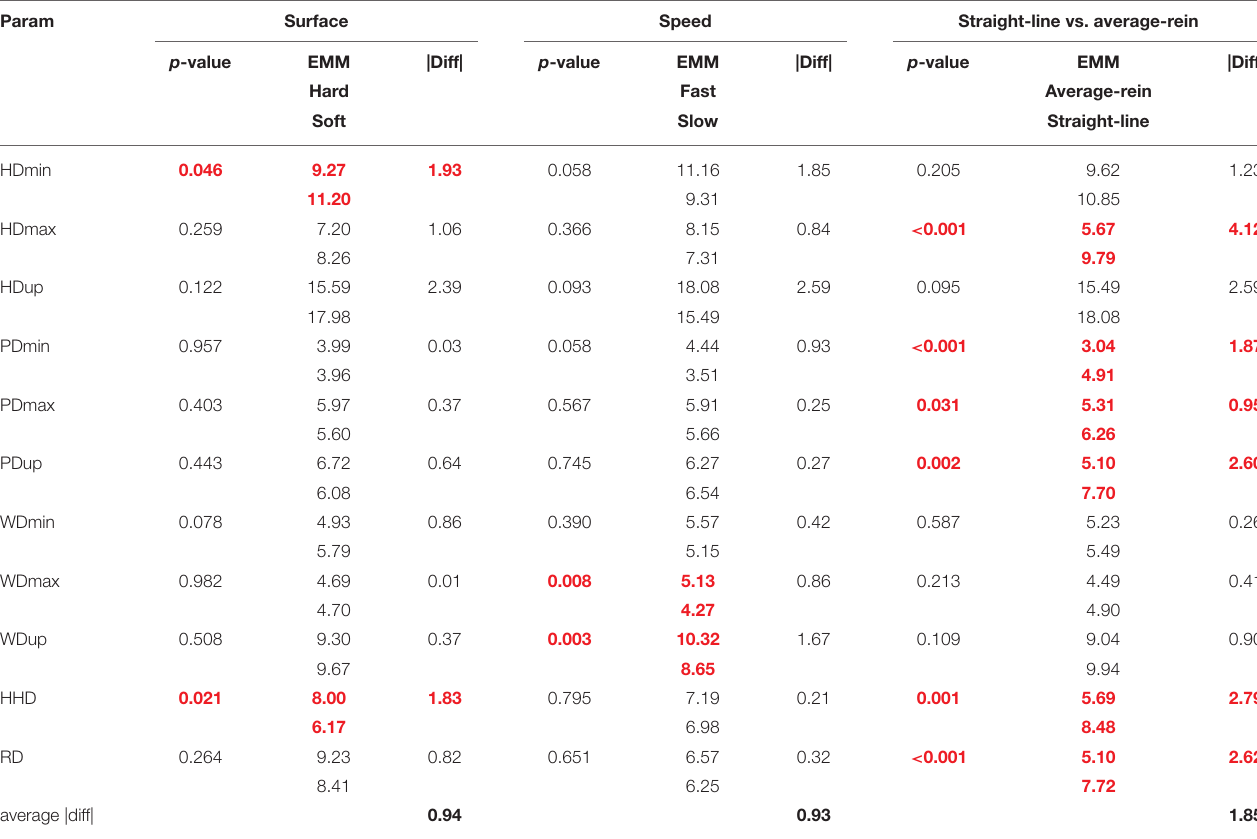
TABLE 4 | p -values and estimated marginal means for mixed linear models for each of 11 normalized movement asymmetry parameters derived from N = 185 in-hand and average-rein (inside/outside rein) assessments. Param Surface Speed Straight-line vs. average-rein